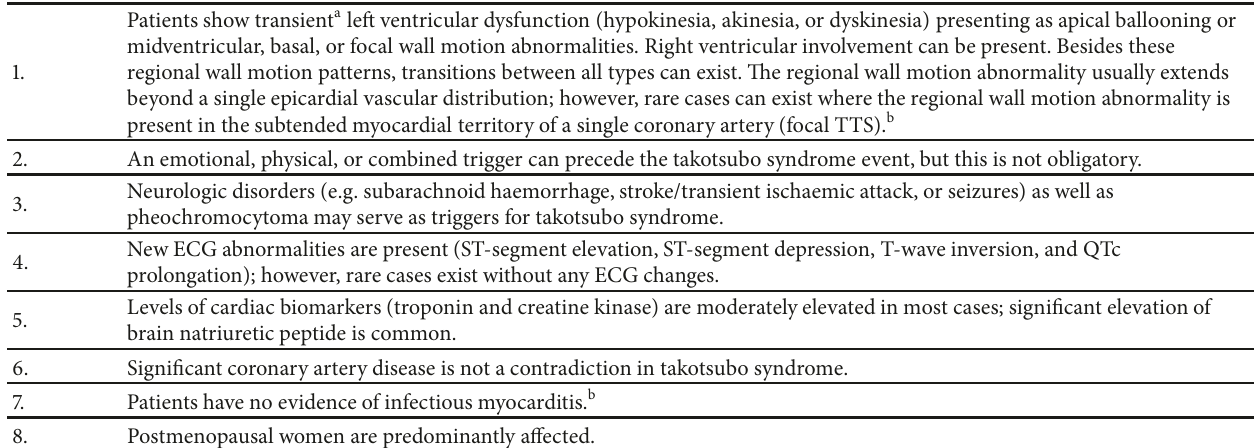
Table 1: International Takotsubo Diagnostic Criteria (InterTAK Diagnostic Criteria) [27].